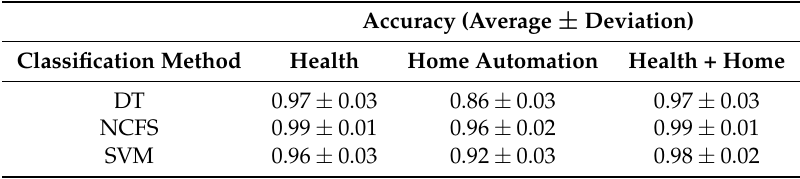
Table 2. Results of the users’ discrimination according to the quantities adopted in the